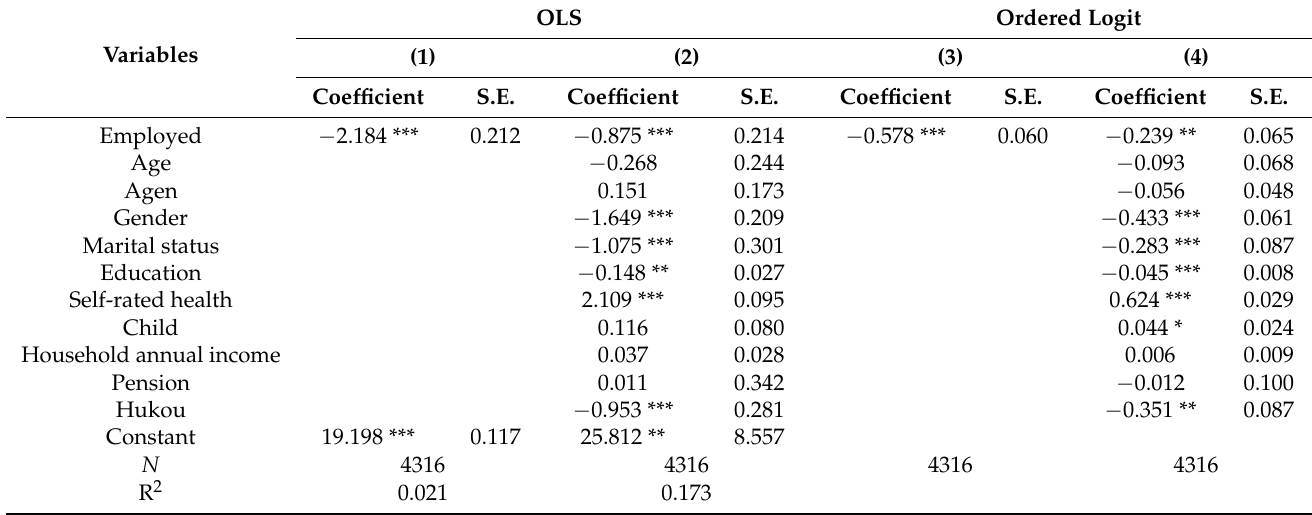
Table 3. Results of OLS and ordered logit.